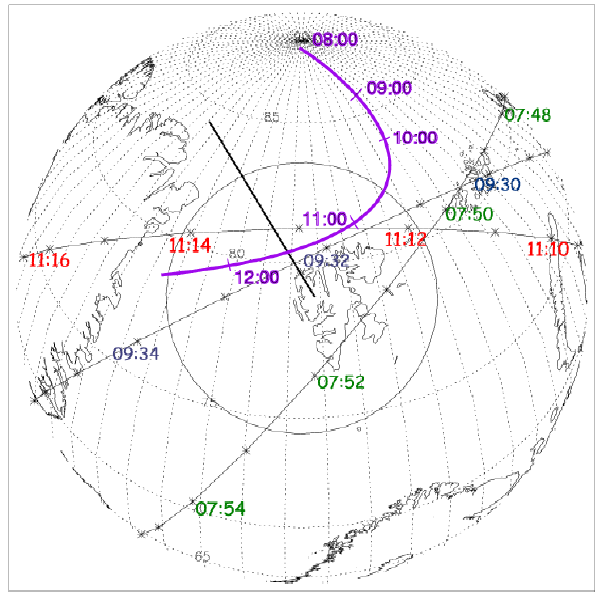
Fig. 2. Map over the Svalbard region showing satellites’ orbits pro- jected along the Earth’s magnetic field lines and the field-of-view of the ESR (thick black line). Cluster footprint is in purple and the 3 successive F13 passes in thin black lines labeled in green, blue and red,